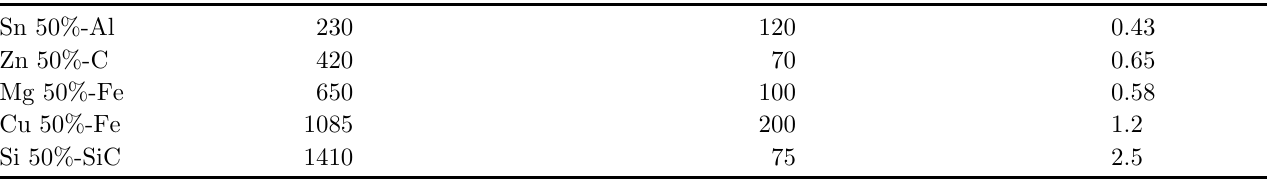
Table 1. Properties of some MGA thermal storage materials [15].